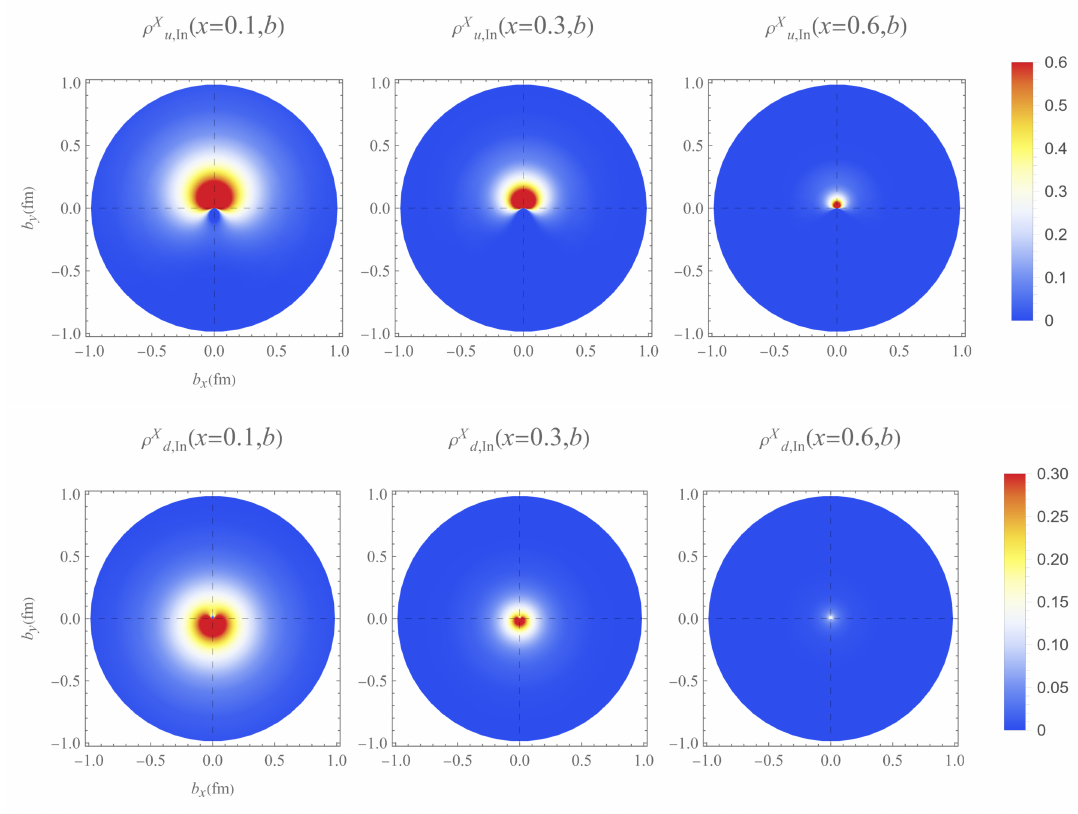
Figure 11 . Plots of the intrinsic quark densities ρ X ( x, b ) for both u (the upper row) and d (the q, In lower row) quarks in transversely polarized proton (in the X direction) with increasing momentum fraction x . Both the u and d quark densities are shifted in the y direction which contribute to the transverse angular momentum J X , while the u contributions are positive ( + y direction) and the d contributions are negative ( − y